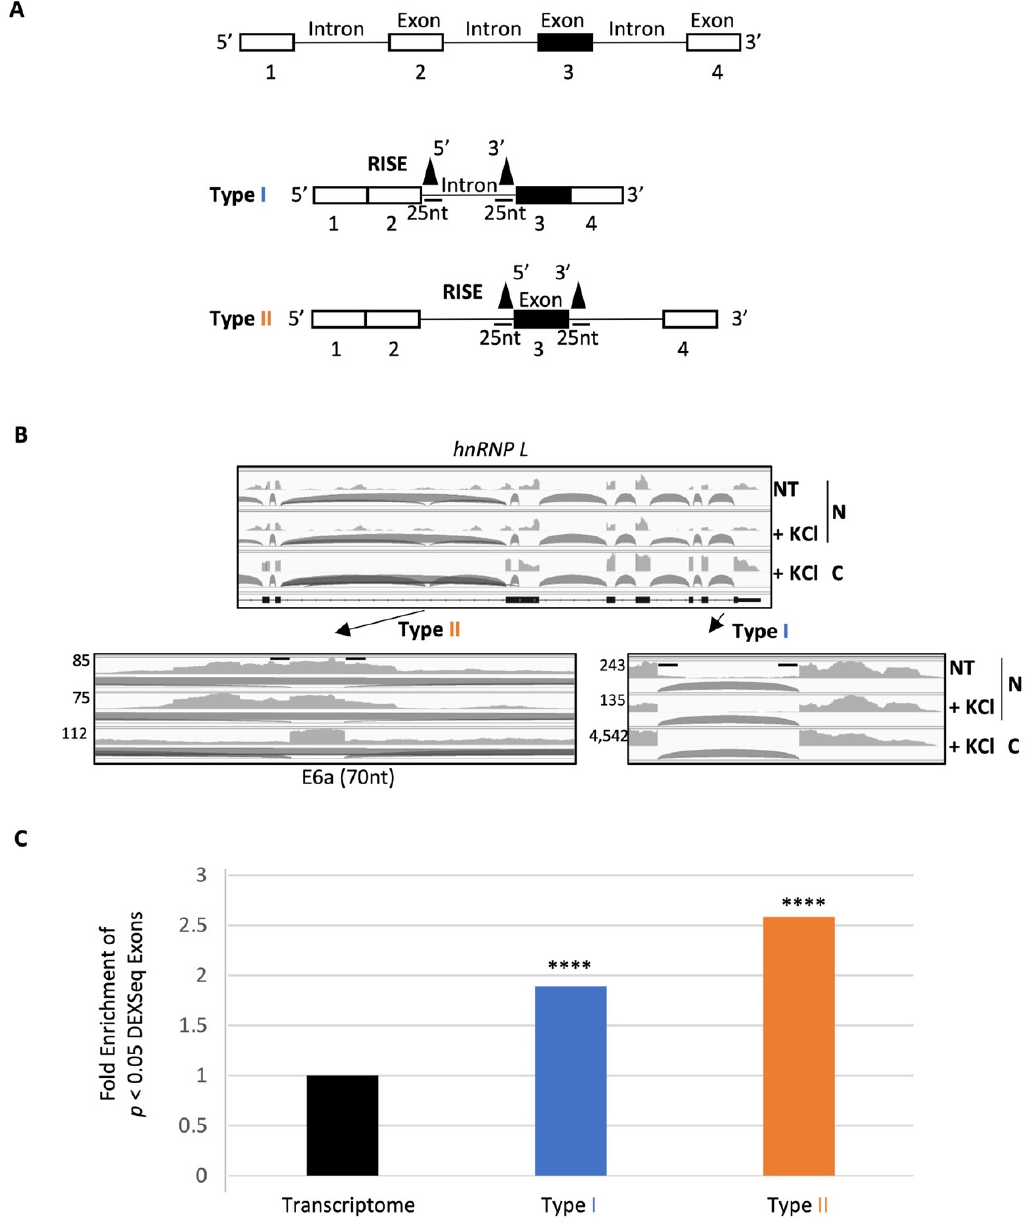
Figure 3. Two types of RISE pairings and their association with depolarization-regulated exons. ( A ) Diagram of RISE pairings across the same intron or exon. Arrowheads: where RISE observed. The horizontal bars represent the typical RISE length used in the analysis. Black boxes: alternative exons, White boxes: constitutive exons already spliced in most pre-mRNA intermediates as deduced by the absence of RISE. ( B ) An example of a pre-mRNA region containing both types of the RISE pairings: an IGV local view of the hnRNP L on chromosome 1 and enlarged regions of the RISE pairings across introns (I) or exons (II). ( C ) Fold enrichment of the percentages of depolarization- regulated exons ( p < 0.05) among either or both types of RISE pairings over that of all such exons (2.9%) detected by DEXSeq analysis of the total RNA (total n = 116,950 exons/bins). ****: p < 2 × 10 − 8 , hypergeometric density test.